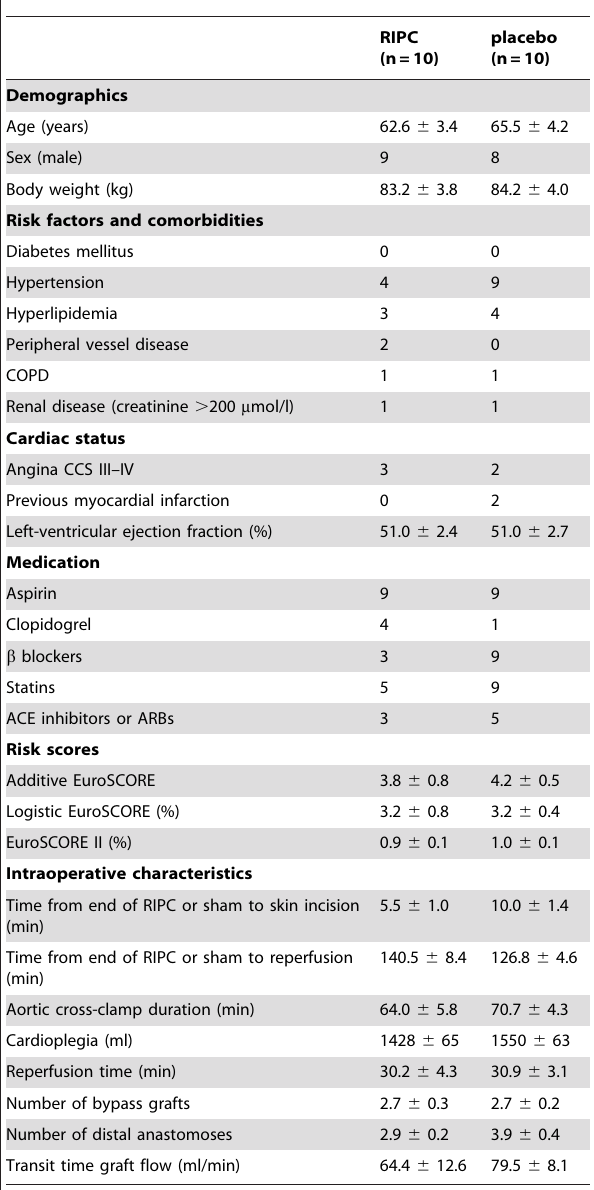
Table 1. Baseline and perioperative characteristics of patients.